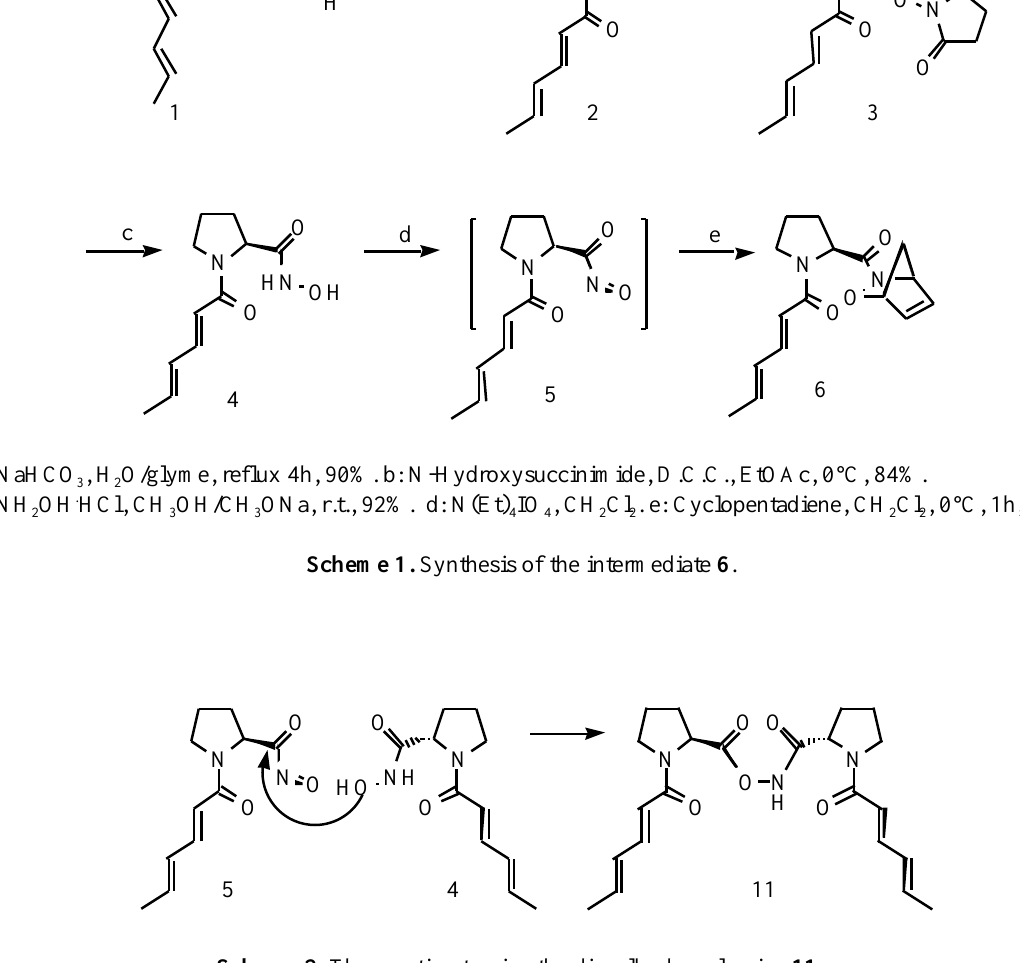
Scheme 2. The reaction to give the diacylhydroxylamine 11